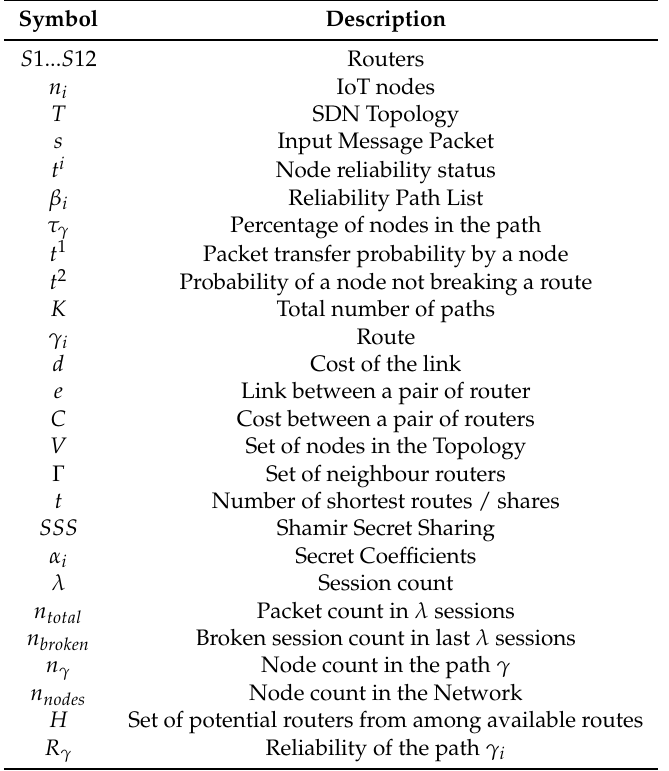
Table 1. Commonly used